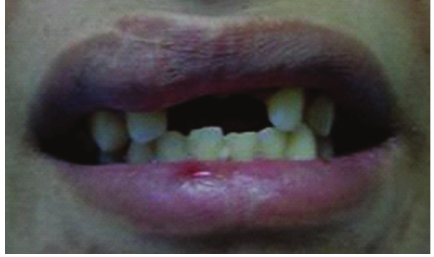
Figure 7: Frontal view of the dentition of patient no. 2.